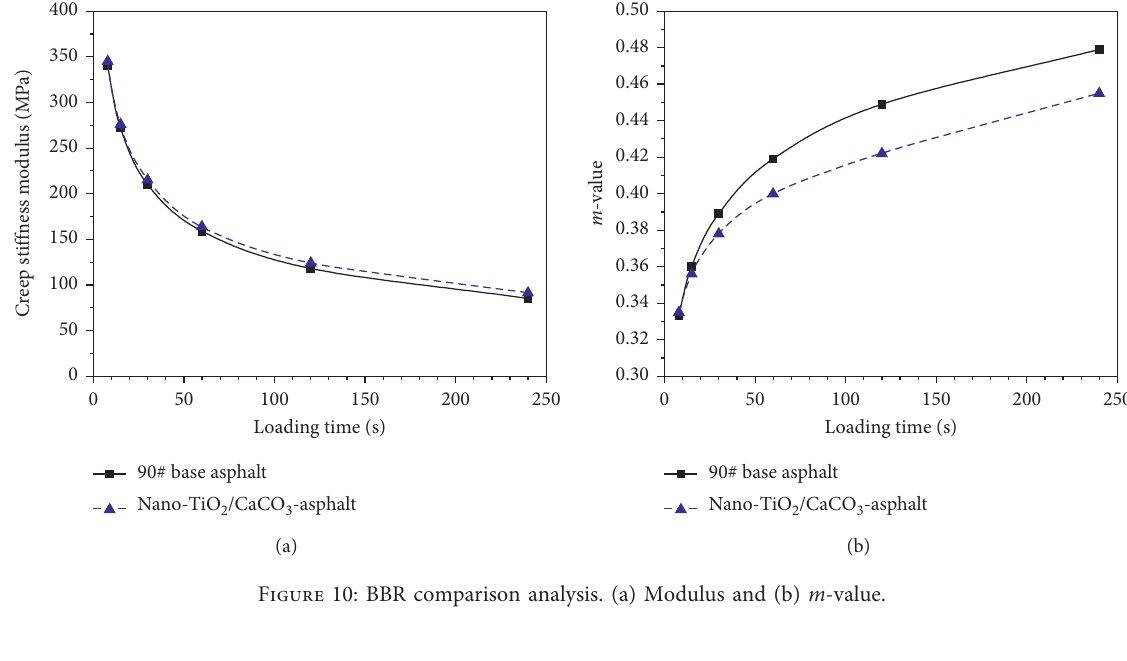
Figure 10: BBR comparison analysis. (a) Modulus and (b) m -value.